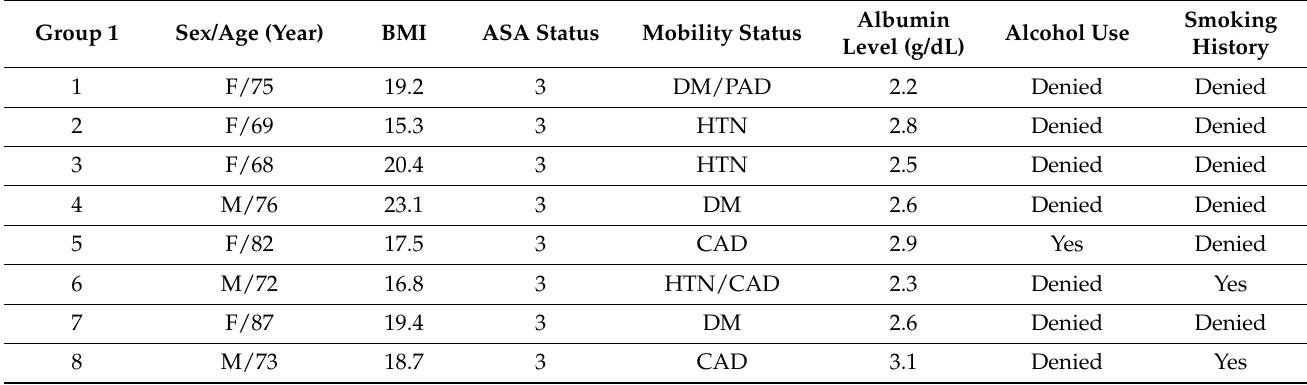
Table 1. Retrospective reviewed data from first 8 patients.